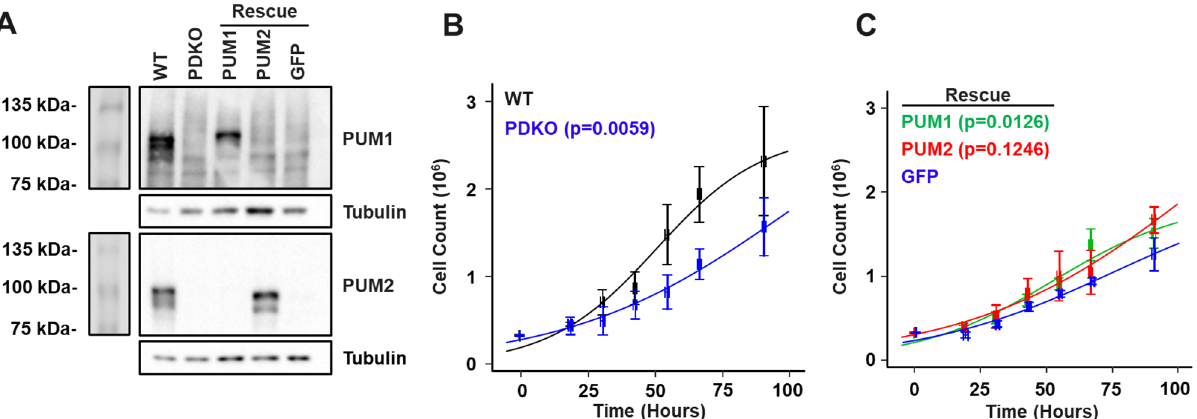
Figure 1. Cell growth rate is modulated by both PUM proteins. ( A ) Western blot for PUM1 and PUM2 in WT, PDKO, and PDKO cells stably transfected with PUM1, PUM2, or GFP. Tubulin serves as a control. ( B ) Growth rates of WT (black) and PDKO (blue) T-REx-293 cells. ( C ) Growth rates of PDKO T-REx-293 cells stably transfected with PUM1 (green), PUM2 (red), or GFP (blue). Growth measurements were calculated from three biological replicates, with error bars representing standard error of the mean. Logistic growth model fits of the data (trend lines) were compared using ANOVA F-test to determine statistical significance. Uncropped original blots, displayed in ( A ), are presented in Supplementary Fig.